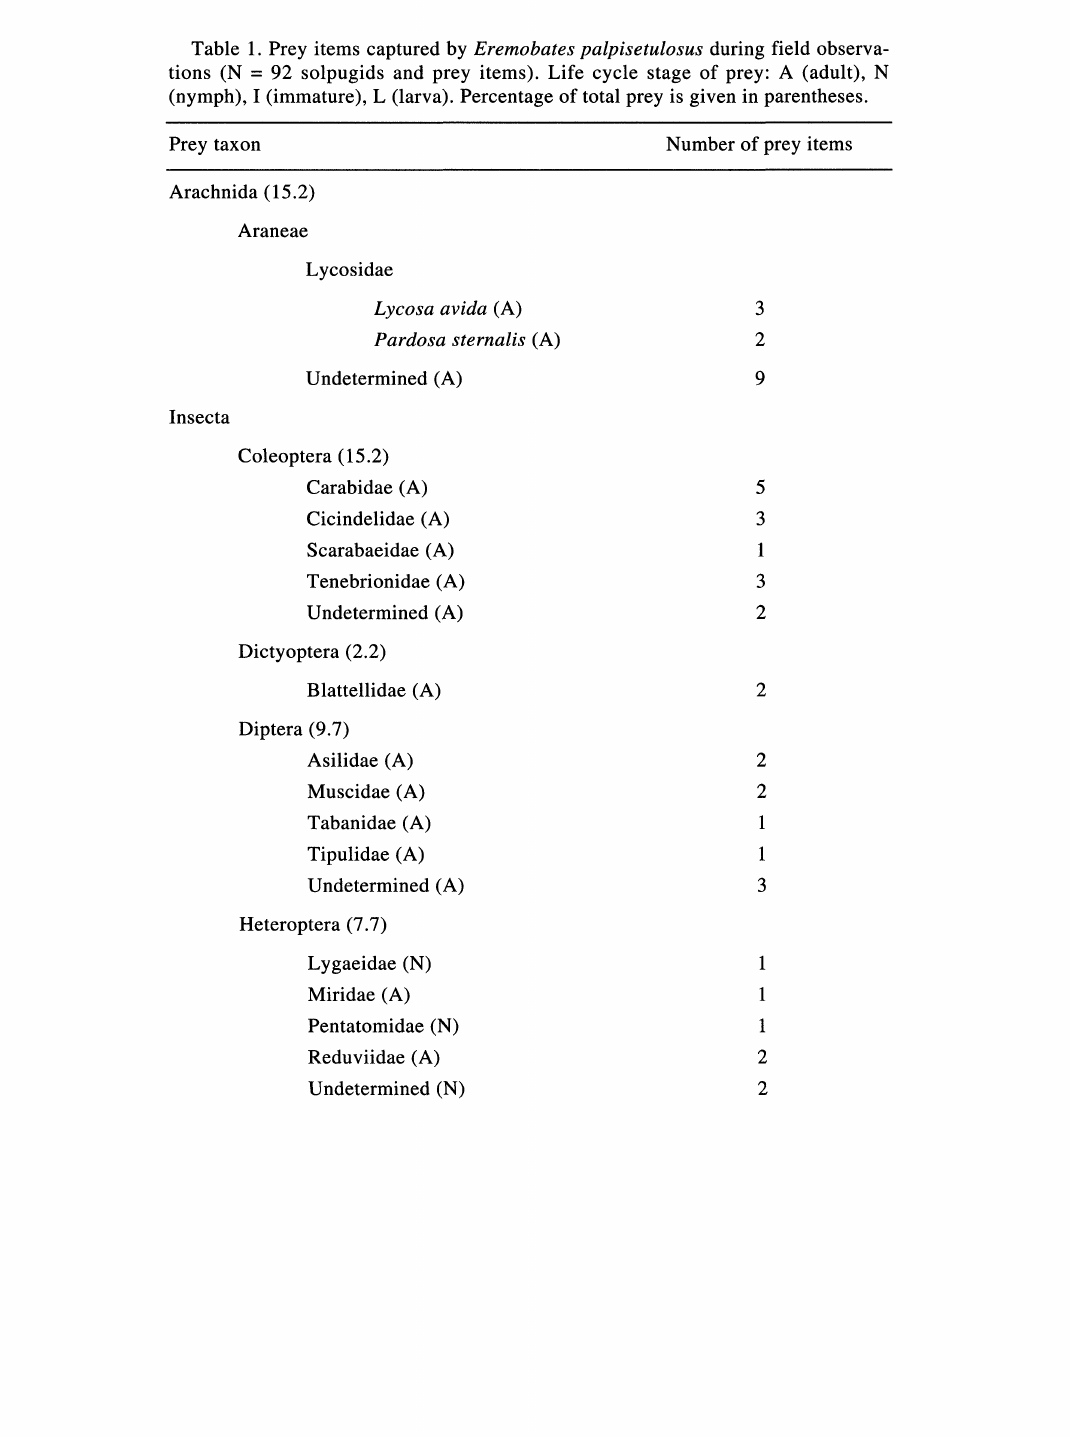
Table 1. Prey items captured by Eremobates palpisetulosus during field observa- tions (N Prey